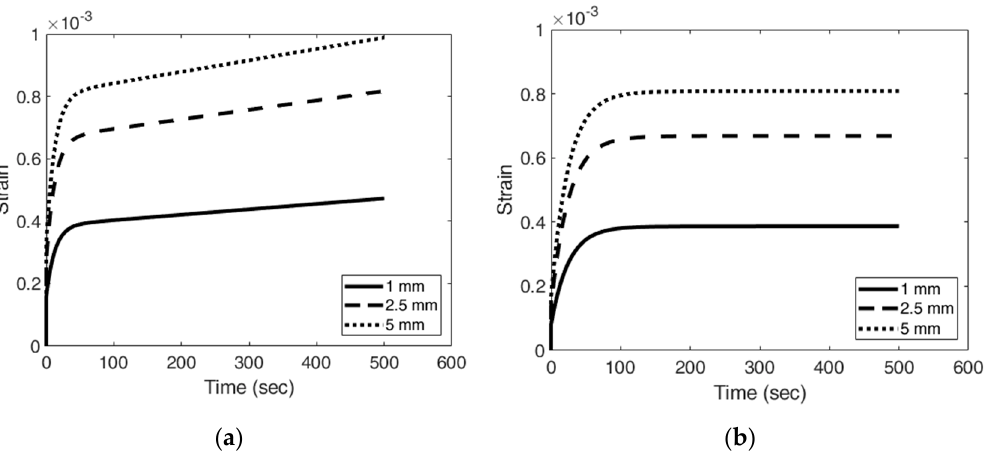
Figure 5. The strain responses over time at different depths along the asymmetric axis of the model in the ramp mode ( a ) and creep mode ( b ).